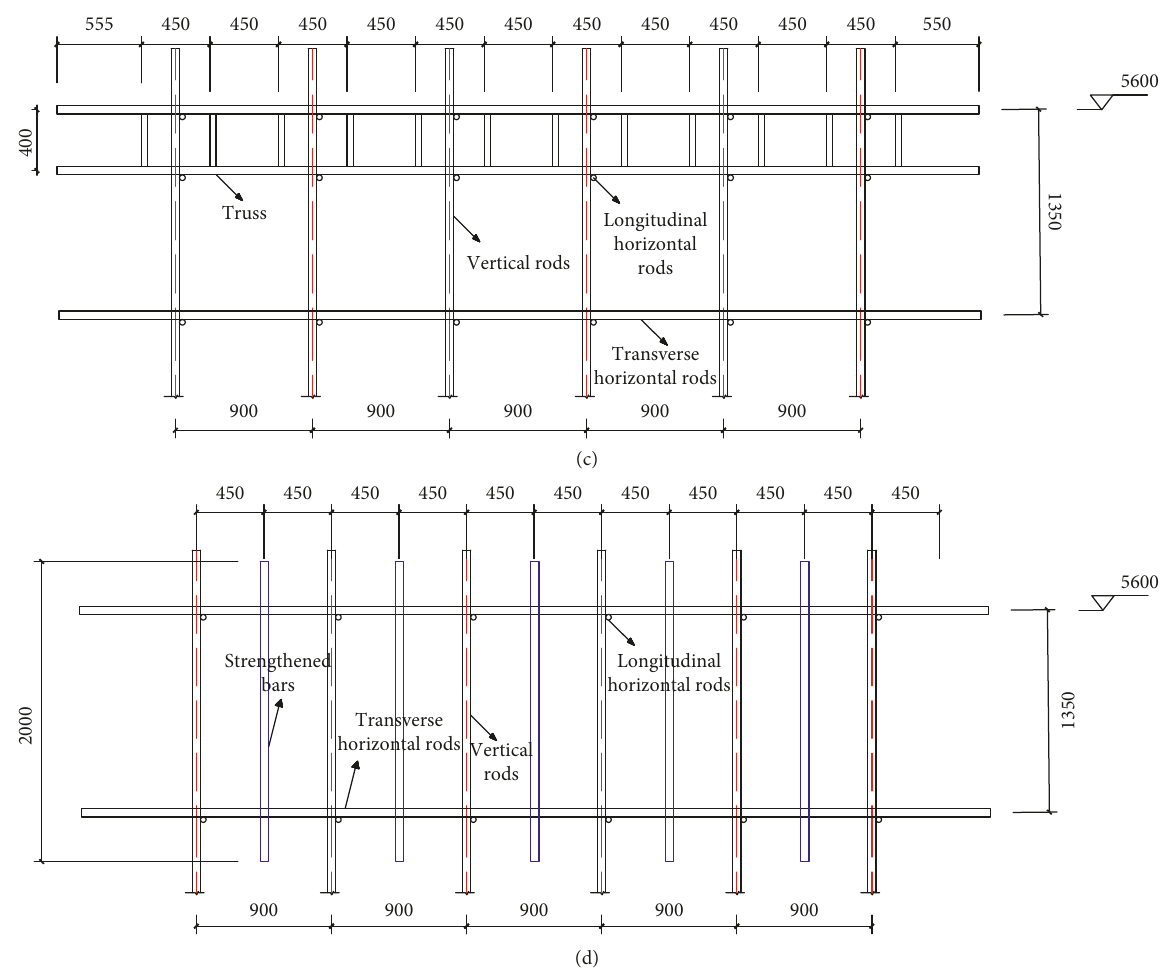
Figure 3: Structural layouts of Models 1, 2, and 3. (a) Plane view. (b) Vertical view. (c) Local view of the top of Model 2. (d) Local view of the top of Model 3.